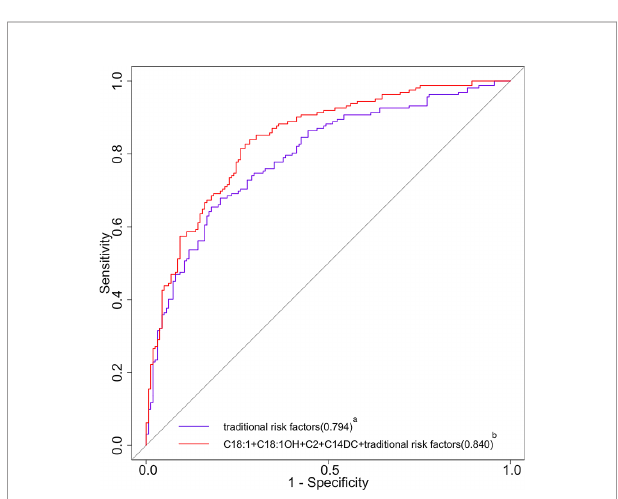
FIGURE 2 | ROC curves of traditional risk factors and traditional risk factors plus acylcarnitine for DR. ROC, receiver operating characteristic; DR, diabetic retinopathy; C18:1, octacarbonylcarnitine; C18:1OH, 3-hydroxy- octadecylcarnitine; C2, acetylcarnitine; C14DC, tetradecanoyldiacylcarnitine. a The purple curve stands for the traditional risk factor model (multivariable model 1 in Table 4 for the list of variables); the area under the operating characteristic curve was 0.794 (95% CI 0.745 to 0.842) for the traditional risk factor model. b The red curve stands for the traditional risk factors plus C18, C18:1OH, C2, and C14DC; the area under the operating characteristic curve was 0.840 (95% CI 0.797 to 0.883) for the traditional risk factor plus C18, C18:1OH, C2, and C14DC (p<0.05 for comparison of the traditional risk factor